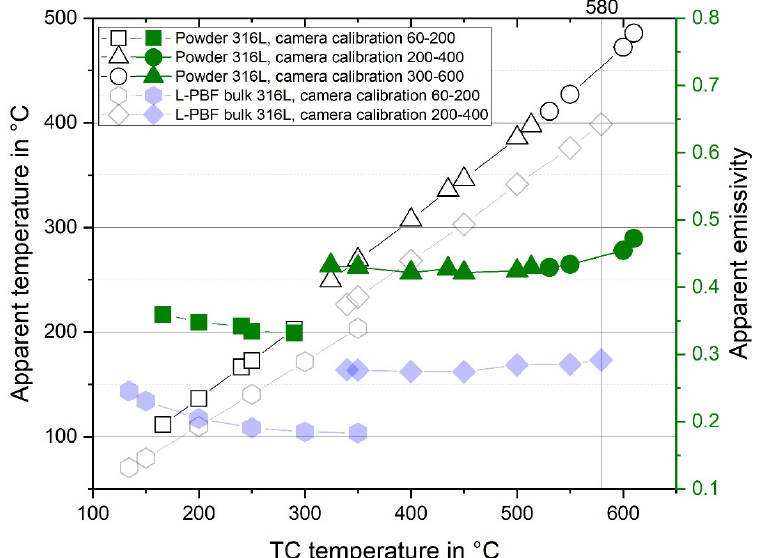
Figure 10. Apparent temperature (black hollow symbols) and apparent emissivity (green full symbols) of the 316L powder layer over measured TC temperature. For comparison, apparent temperature (gray hollow symbols) and apparent emissivity (blue full symbols) of the 316L L-PBF bulk surface over TC temperature are also depicted.